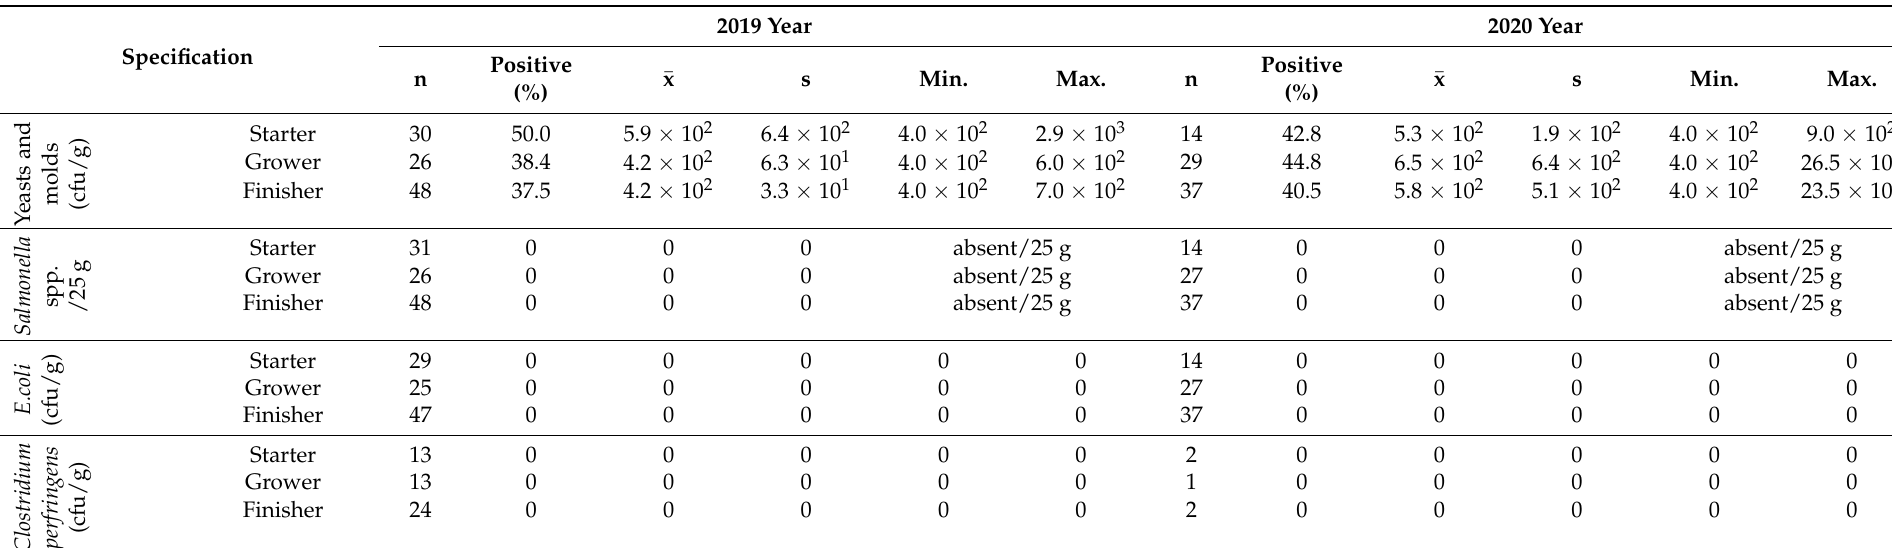
Table 2. Results of microbiological assessment of compound